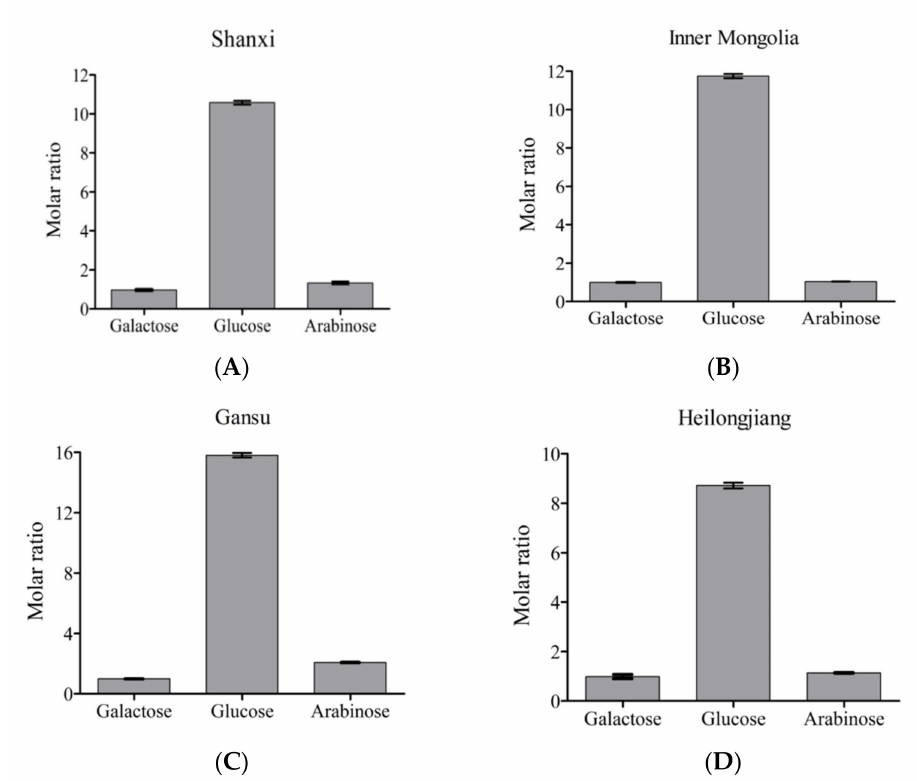
Figure 2. Monosaccharide compositions of APSs from four origins. ( A ), Shanxi; ( B ), Inner Mongolia; ( C ), Gansu; ( D ),